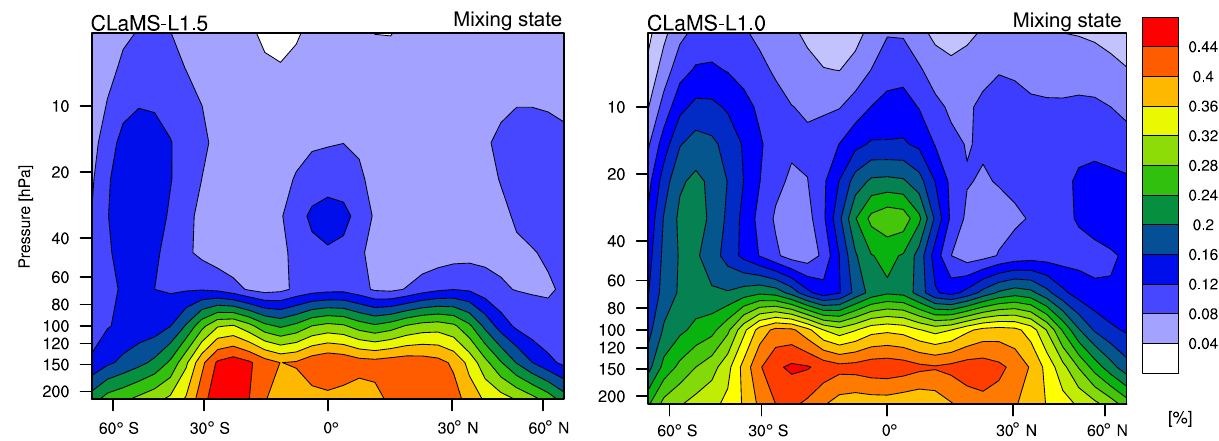
Figure 6. Diagnosed small-scale mixing intensity (estimated as the number of grid points influenced by the parametrized CLaMS mixing in %) for the simulations CLaMS-L1.5 (left) and CLaMS-L1.0